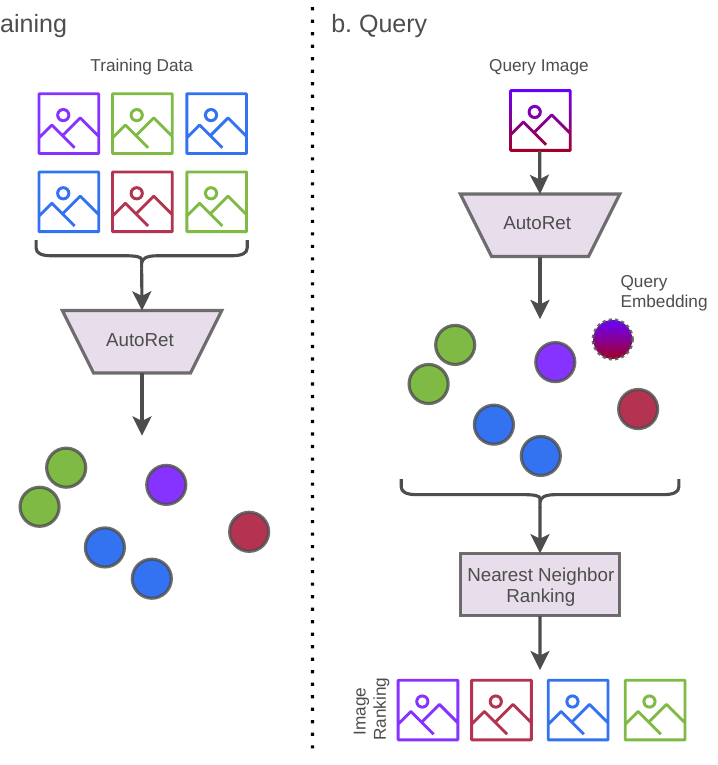
Figure 1. The training policy of AutoRet only includes DCNN architecture using the AutoEmbedder framework (illustrated in ( a )). After completing the training, the trained DCNN architecture is directly used to generate image embeddings. The image embeddings of the query image and retrievable images are stored. Finally, a similarity search is conducted using a nearest neighbor algorithm based on the query image’s embedding (illustrated in ( b